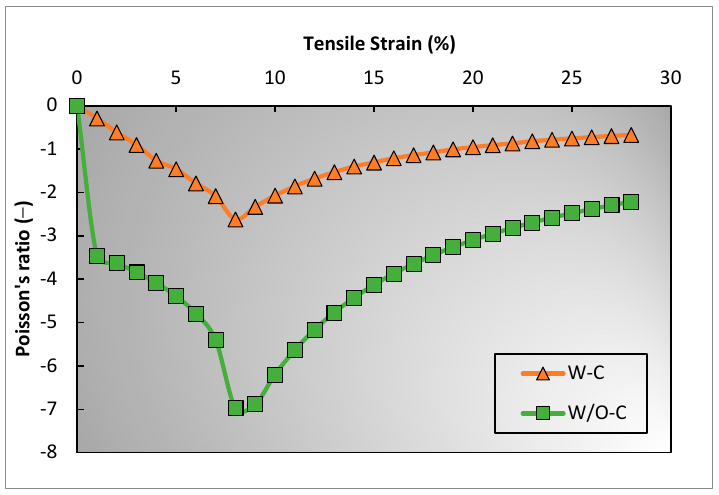
Figure 12. Effect of binding yarn’s compression on auxetic behavior of 3D woven structure.